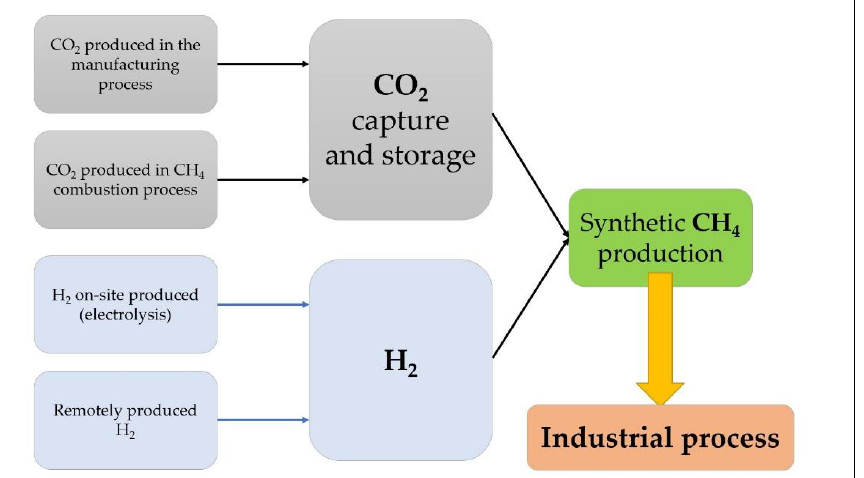
Figure 1. Power to Gas technology (PtG).